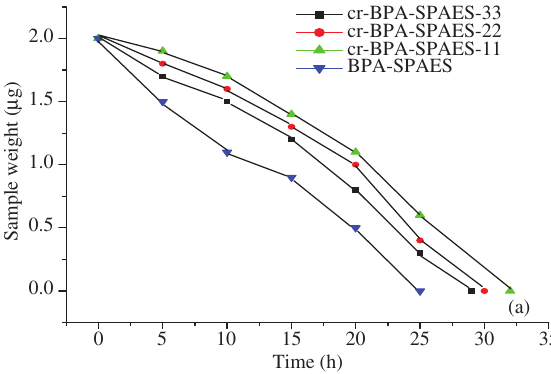
Figure 6: Oxidative stability of the BPA-SPAES and its cr-BPA-SPAES membranes at 30 °